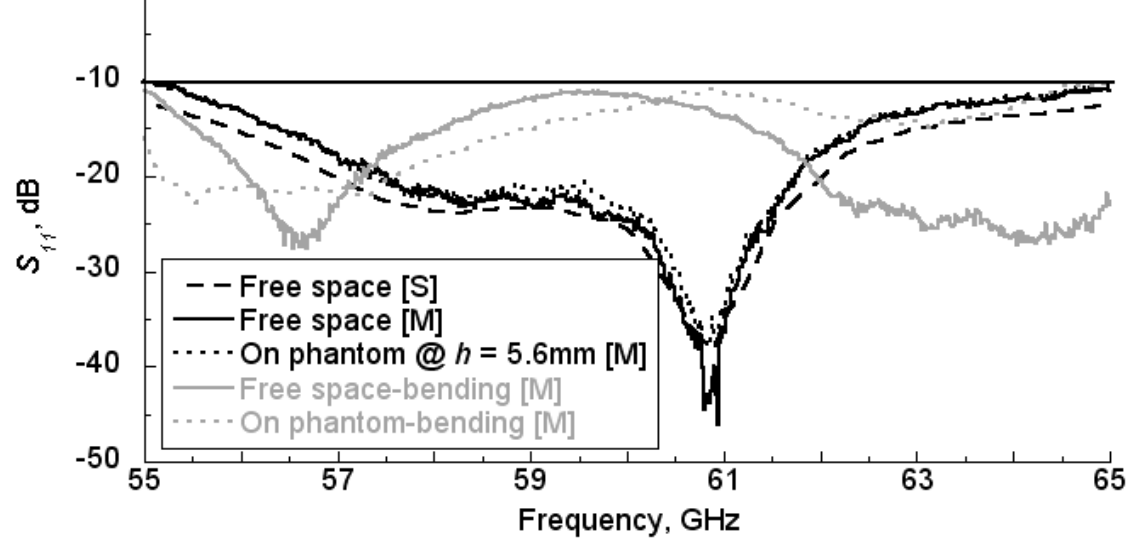
Figure 2. Reflection coefficient of the antenna in free space, under bending conditions on a semi-cylindrical foam and on a skin-equivalent phantom, and for the antenna placed on the phantom for the antenna/body spacing h = 5.6 mm. [S]—Simulations, [M]—Measurements.